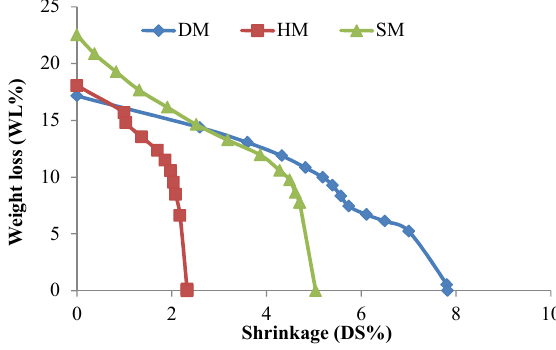
Figure 8. Bigot’s drying curves of DM, HM, and SM clays.